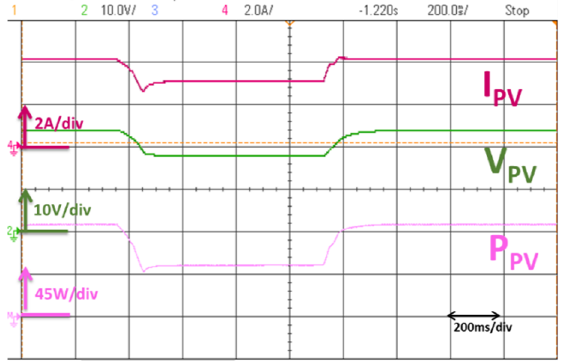
Figure 15. Proposed fixed-frequency predictive MPPT operation waveforms after removing the partial shading condition (step up in the irradiation) (Ch2 (green) is PV voltage, Ch4 (pink line) is the PV current), the PV extracted power (lavender line).